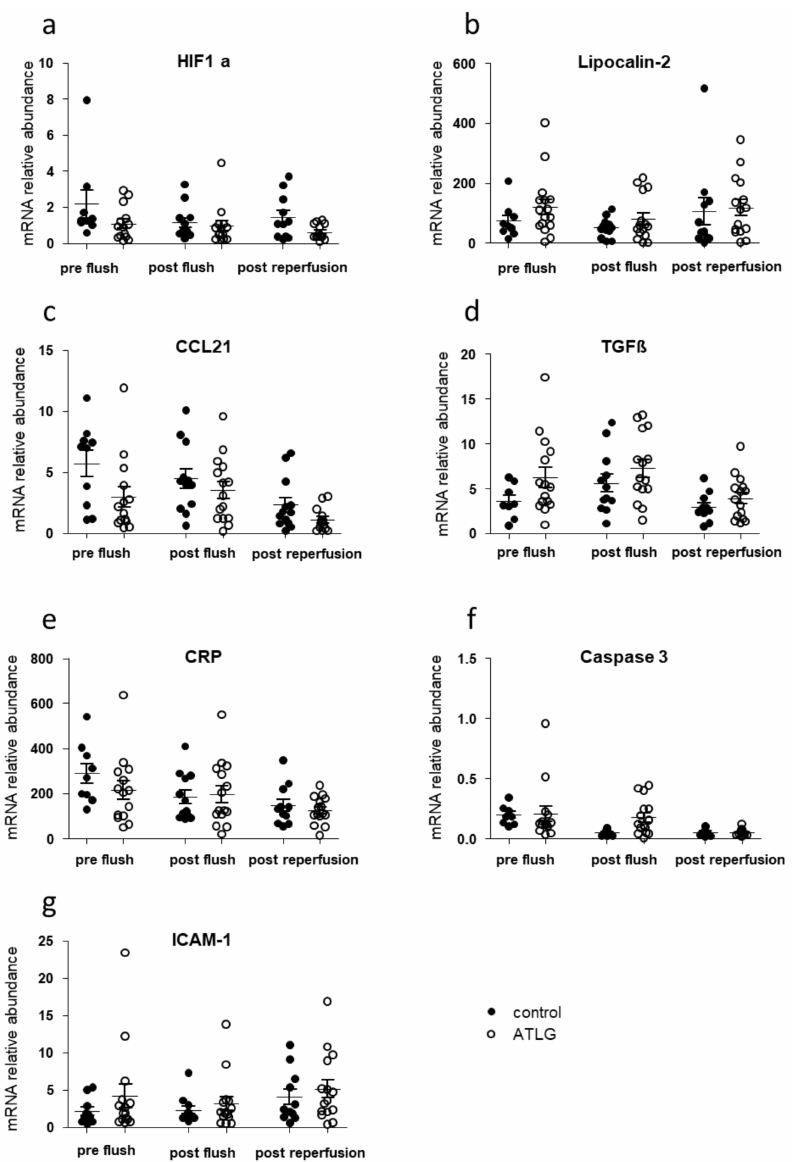
Figure 3. Inflammation-related candidate gene expression in liver biopsies taken before ATLG perfusion, after ATLG perfusion, and one hour post-reperfusion. Real-time quantitative PCRs of mRNA of whole tissues were performed at different time points perioperatively. Selected candidate markers ( a ) HIF1a, ( b ) Lipocalin-2, ( c ) CCL21, ( d ) TGF β , ( e ) CRP, ( f ) Caspase 3, ( g ) ICAM-1), which play major roles in the context of inflammation, and cell adhesion did not show significant differences before perfusion with ATLG (pre-flush), directly after perfusion with ATLG (post-flush), or following reperfusion (post-reperfusion) between ATLG-perfused livers and control livers. ATLG: open circles; control: filled circles. Data are presented as mean ± SEM; ATLG—anti-human T-lymphocyte globulin; CCL21—chemokine (C-C motif) ligand 21; CRP—C-reactive protein; HIF1a—hypoxia-inducible factor 1-alpha; ICAM-1—intercellular adhesion molecule 1; TGF β —transforming growth